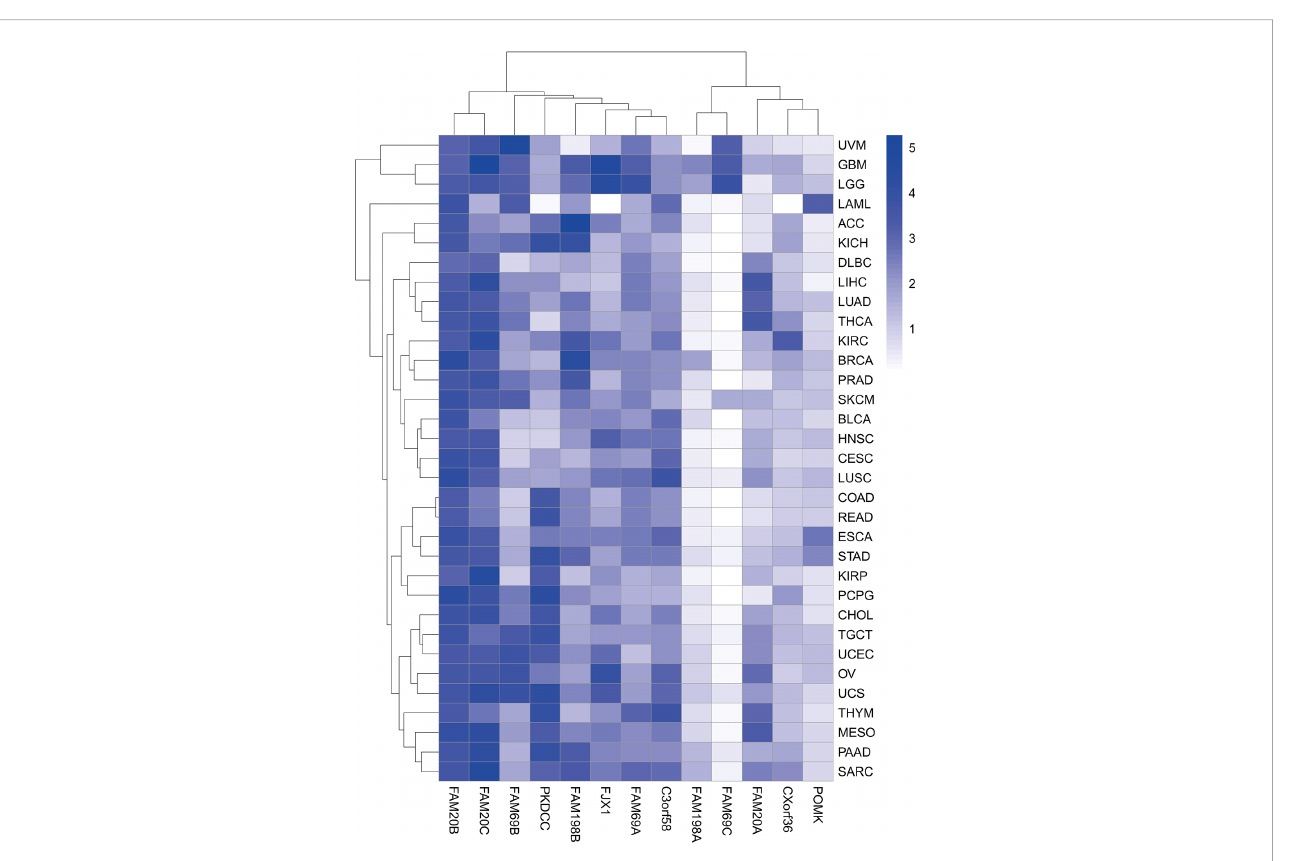
FIGURE 2 Heatmap of gene expression in pan-cancer. Heatmap showing the association of 13 genes encoding secretory pathway kinases or kinase-like proteins with indicated cancer types in the TCGA pan-cancer RNA sequencing dataset downloaded from UCSC Xena (https://xena.ucsc.edu). The color code represents the expression level of the 13 genes, with the most signi fi cant high expression in dark